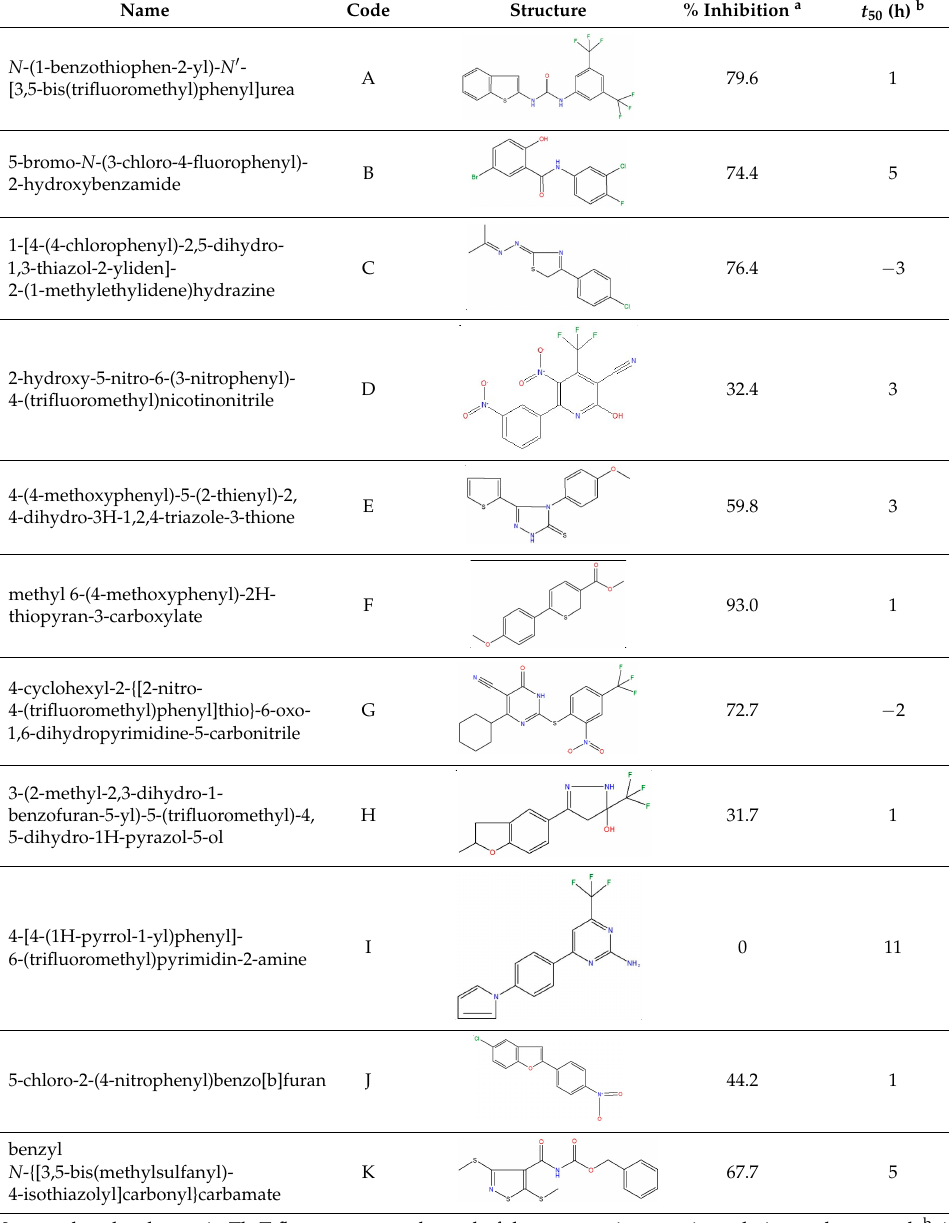
Table 1. Representative active compounds identified in the high-throughput screening. Table1. Representative active compounds identified in the high-throughput screening. Table1. Representative active compounds identified in the high-throughput screening. Table1. Representative active compounds identified in the high-throughput screening. Table1. Representative active compounds identified in the high-throughput screening. Table1. Representative active compounds identified in the high-throughput screening. Table1. Representative active compounds identified in the high-throughput screening. Table1. Representative active compounds identified in the high-throughput screening. Table1. Representative active compounds identified in the high-throughput screening. Table1. Representative active compounds identified in the high-throughput screening. Table1. Representative active compounds identified in the high-throughput screening. Name Name Code Name Code Table1. Representative active compounds identified in the high-throughput screening.